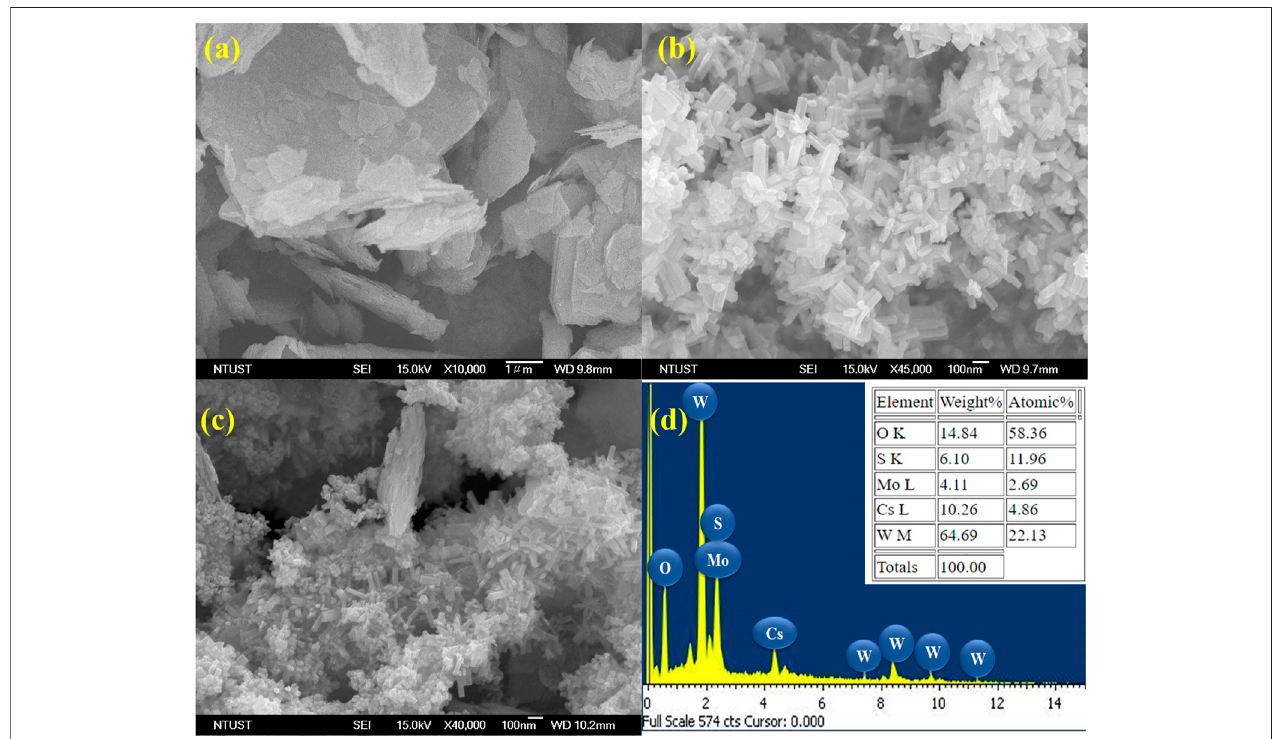
FIGURE 2 | FESEM images of (A) MoS 2 nanosheets; (B) Cs x WO 3 nanorods; (C) Cs x WO 3 /MoS 2 composites and (D) EDS Spectrum of 15% Cs x WO 3 /MoS 2 nanocomposites.